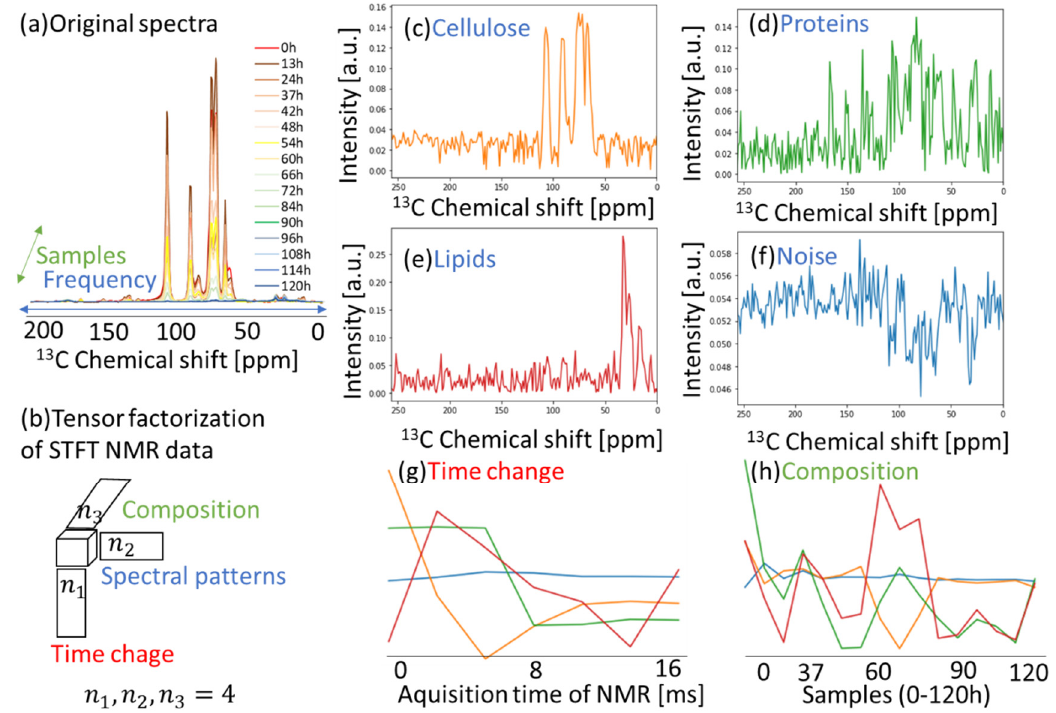
Figure 2. Application of non-negative Tucker decomposition (NTD) to 13 C cross-polarization–magic-angle spinning (CP- MAS) in the cellulose degradation process. ( a ) Original spectra of 13 C CP-MAS in cellulose degradation process. ( b ) Tensor factorization of STFT–NMR signals. ( c – f ) Spectral patterns (cellulose, lipids, proteins, and noise) when signals were separated into four components. ( g ) Time change of separated components. ( h ) Composition of separated components.